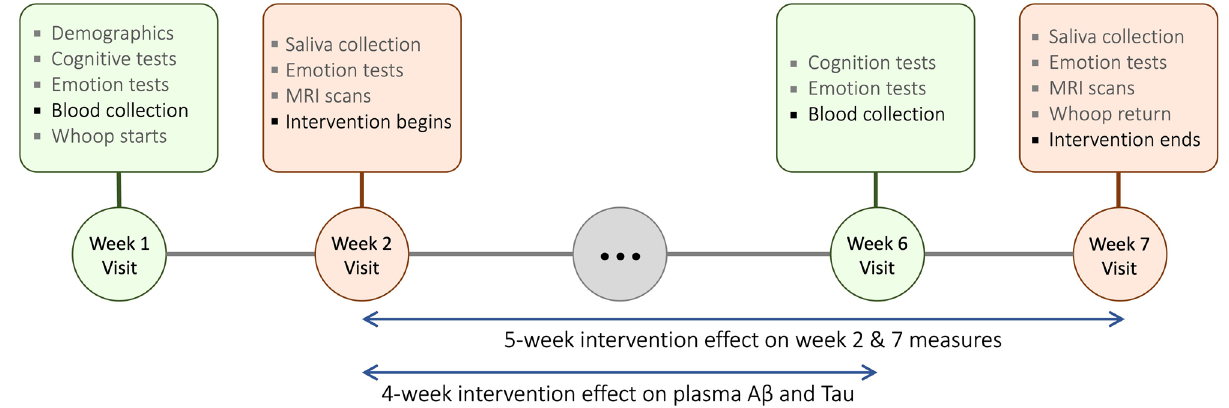
Figure 2. Weekly lab visit schedule. Schedules from Week 3 to 5 were not included because the visits were irrelevant to the measures reported in the current study. Detailed descriptions for each week can be found in the main outcome report of the intervention 30